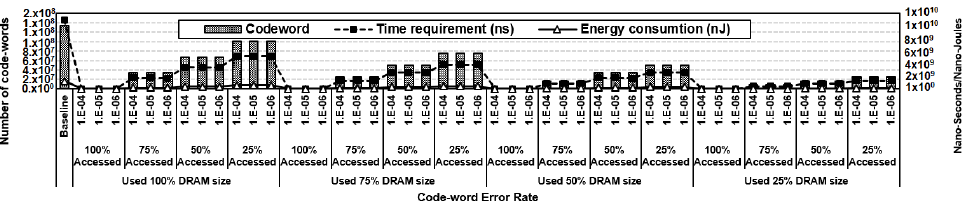
Figure 9. Scrubbing codewords, scrubbing time, and scrubbing energy evaluation results of OBET scrubbing on 16 GB DDR5.